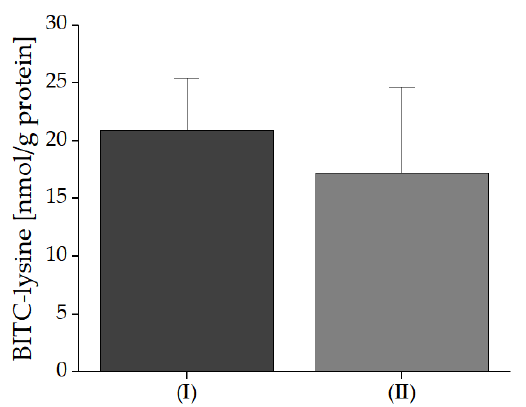
Figure 6. Formed BITC-Lys conjugates in bread with freeze-dried nasturtium (application No. I) and garden cress microgreens (application No. II) mixed into the dough. The breads were prepared and analyzed in triplicate. The initial amount of BG in the breads differs around 40%, but the amounts of BITC-Lys conjugates differed in a range of 10% per gram bread. Therefore, the addition of 4% homogenized nasturtium leaves resulted only in a 10% higher concentration of BITC-Lys conjugation compared to the addition of 1.5% fresh garden cress.